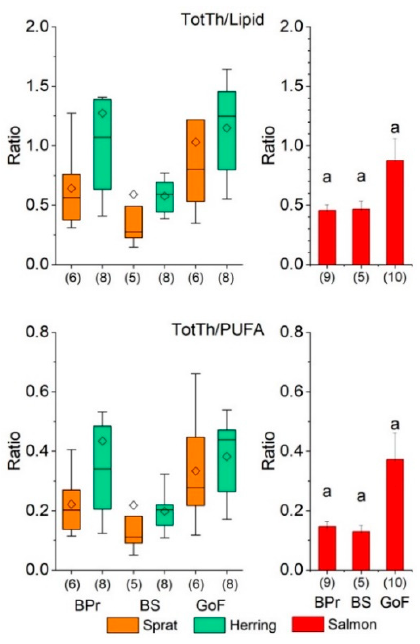
Figure 4. Ratios of total thiamine concentration to total lipid (TotTh/Lipid) and PUFA (TotTh/PUFA) concentration in the whole body of sprat ( Sprattus sprattus ) and herring ( Clupea harengus ) (with the samples of different ages in the fall and spring combined), and salmon ( Salmo salar ) (TotTh in muscle and lipids in the whole body) from the Baltic Proper (BPr), the Bothnian Sea (BS), and the Gulf of Finland (GoF). For further details, see the legend for Figure 2.